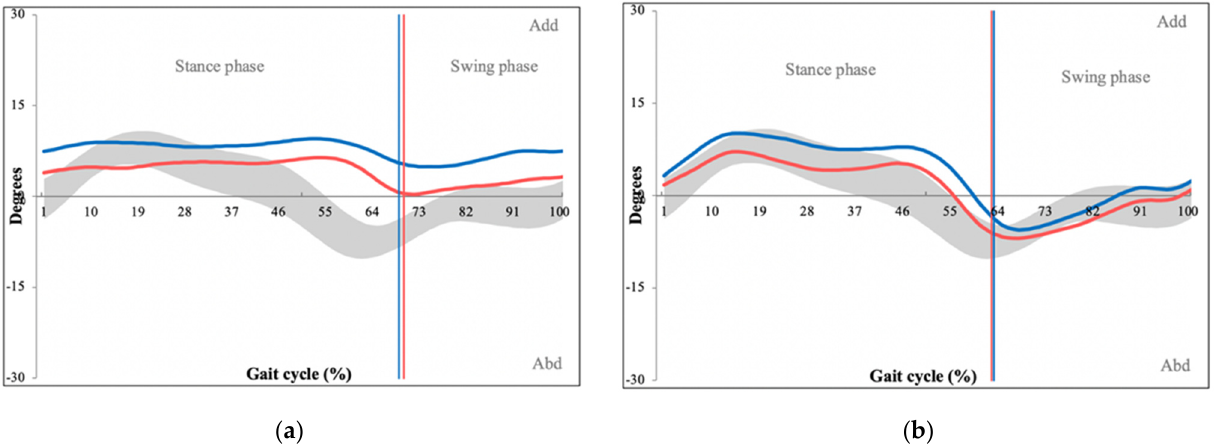
Figure 6. Kinematic graphs of hip abduction/adduction of a patient with LSS ( a ) and their matched control ( b ), demonstrating limited hip abduction throughout the gait cycle. Degrees of movement are shown on the vertical axis whereas the horizontal axis portrays the gait cycle. (Red line—left leg values, blue line—right leg values, grey space—normative values of hip abduction/adduction.) Significant differences were also found between both pelvic cranial/caudal tilt (PG = 3.20, CG = 1.82, p = 0.034) and pelvic internal/external rotation (PG = 5.31, CG = 3.44, p < 0.001). Kinematic graphs demonstrated atypical ‘flat curves’, representing a lower range of pelvic motion for both pelvic parameters (Figure 7).